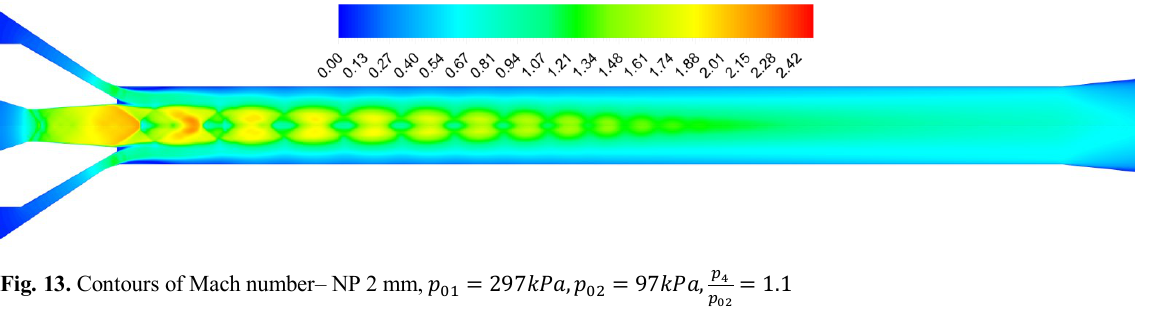
01 = 297𝑘𝑃𝑎,𝑝 02 = 97𝑘𝑃𝑎,